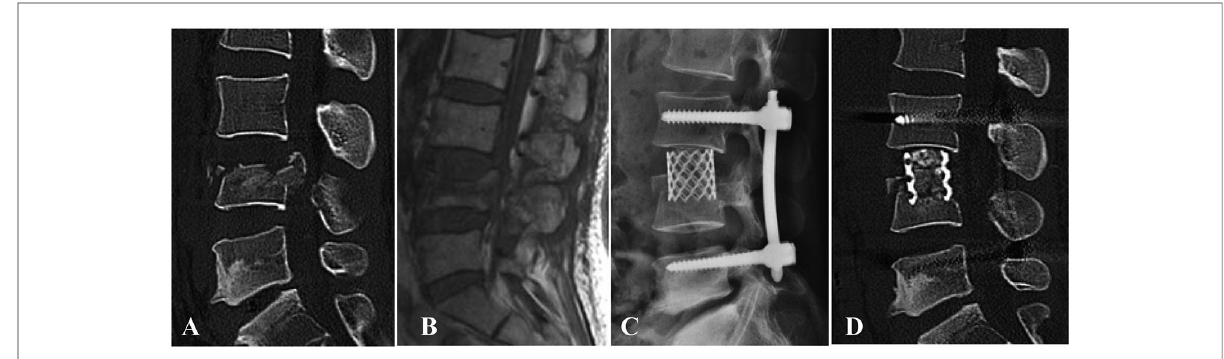
FIGURE 5 A patient with L4 burst fracture underwent posterior instrumentation combined with AIPA monosegmental reconstruction, in which the inferior endplate and disc below were preserved. ( A,B ) Preoperative sagittal CT scan and MRI images. ( C,D ) Postoperative x-ray and CT image demonstrating good correction of kyphotic deformity via posterior instrumentation combined with anterior decompression and titanium cage